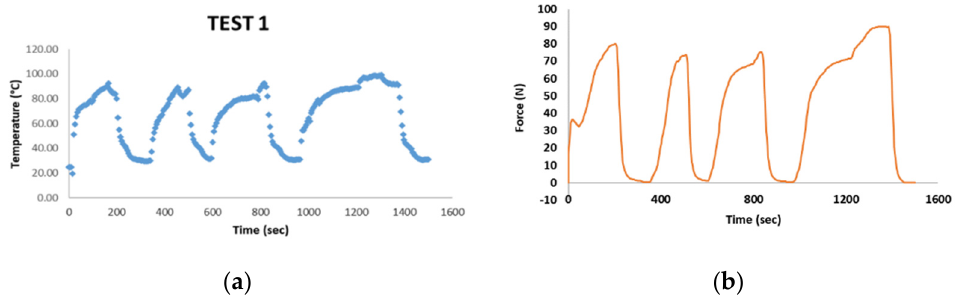
Figure 19. Experimental test results with a heat peak achieved of 90 °C: ( a ) temperature–time, ( b )